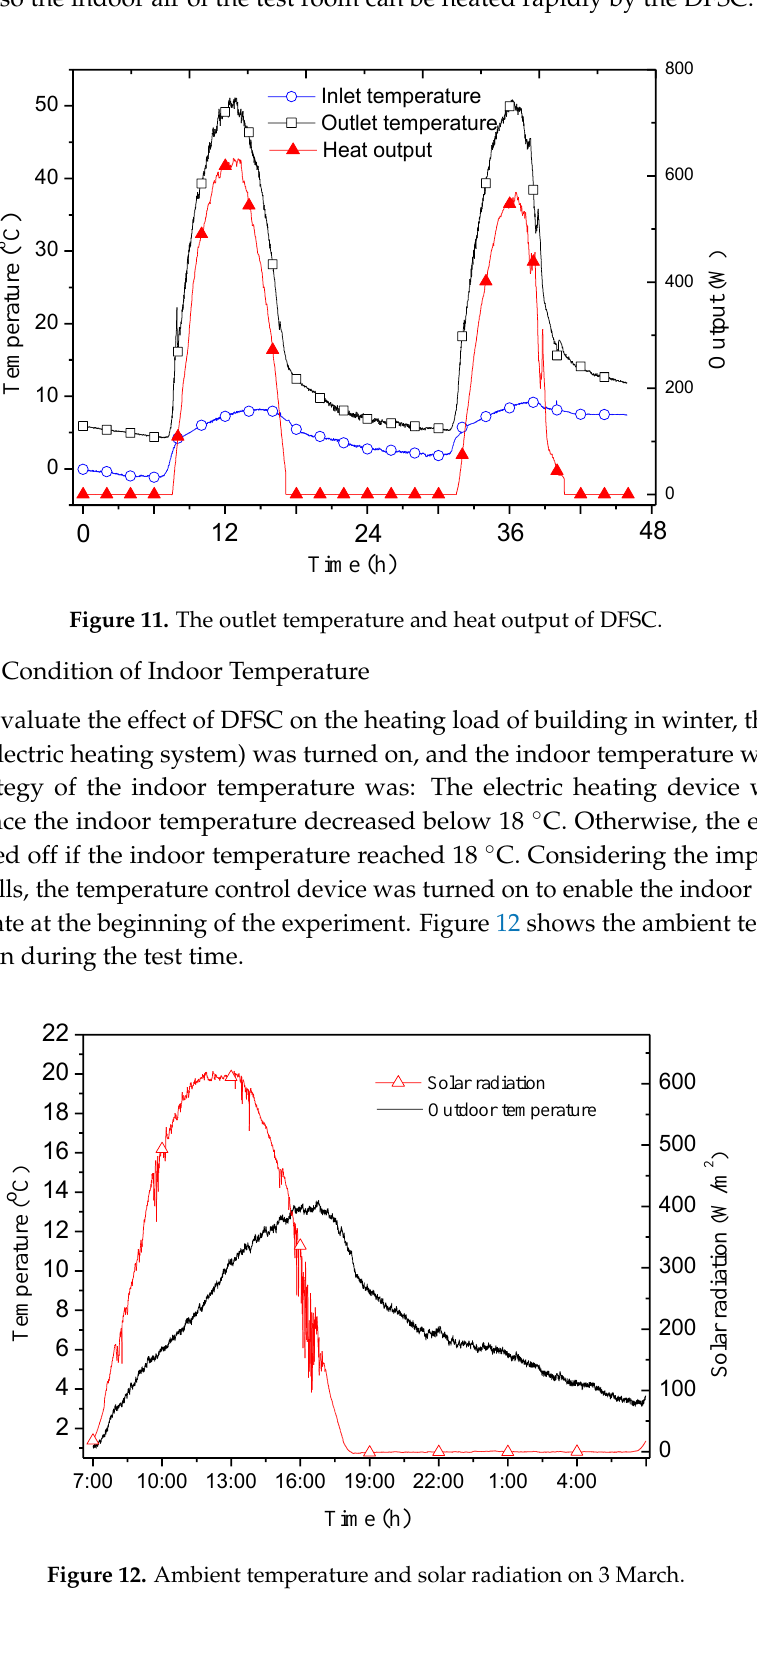
Figure 10. The average temperature of indoor air of the test and reference rooms.